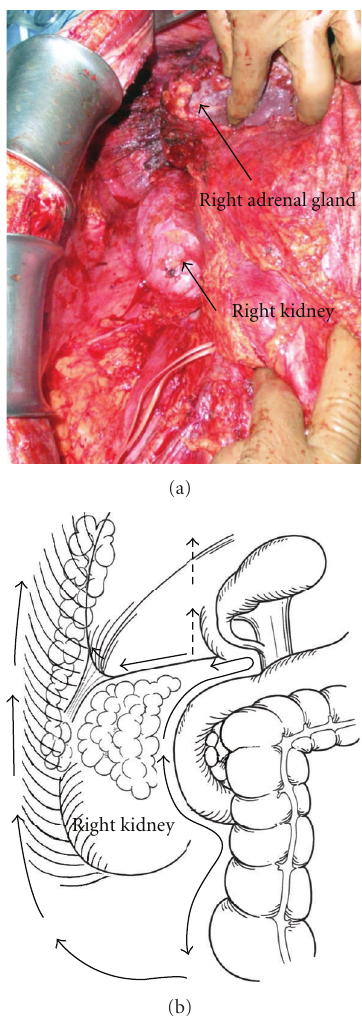
Figure 12: Dissection line of Morrison’s pouch. The peritoneum covering Morrisons’s pouch is removed with the peritoneum on the right paracolic gutter, right subdiaphragm, and right abdominal